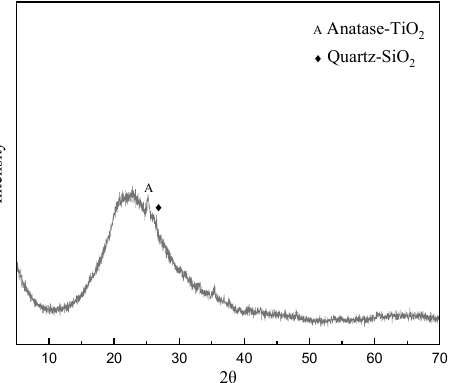
Figure 1. The XRD diagram of the K-1300 metakaolin that was used in this